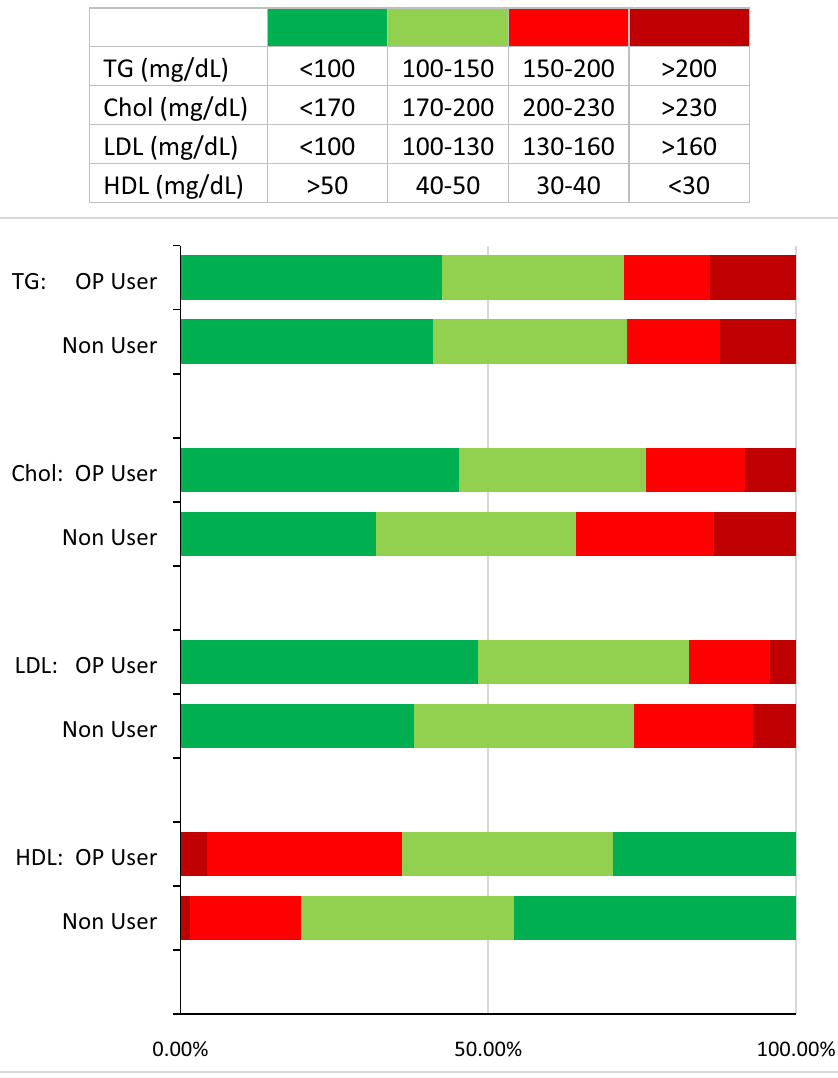
Figure 3. Percentage of participants with normal and abnormal levels of lipid profile in both user and non-user groups of opium. The normal range was presented as green (dark green as healthy and light green as normal borderline) and the abnormal range was presented as red color (light red as abnormal borderline and dark red as unhealthy). The levels of TG, cholesterol, LDL, and HDL were presented in the above